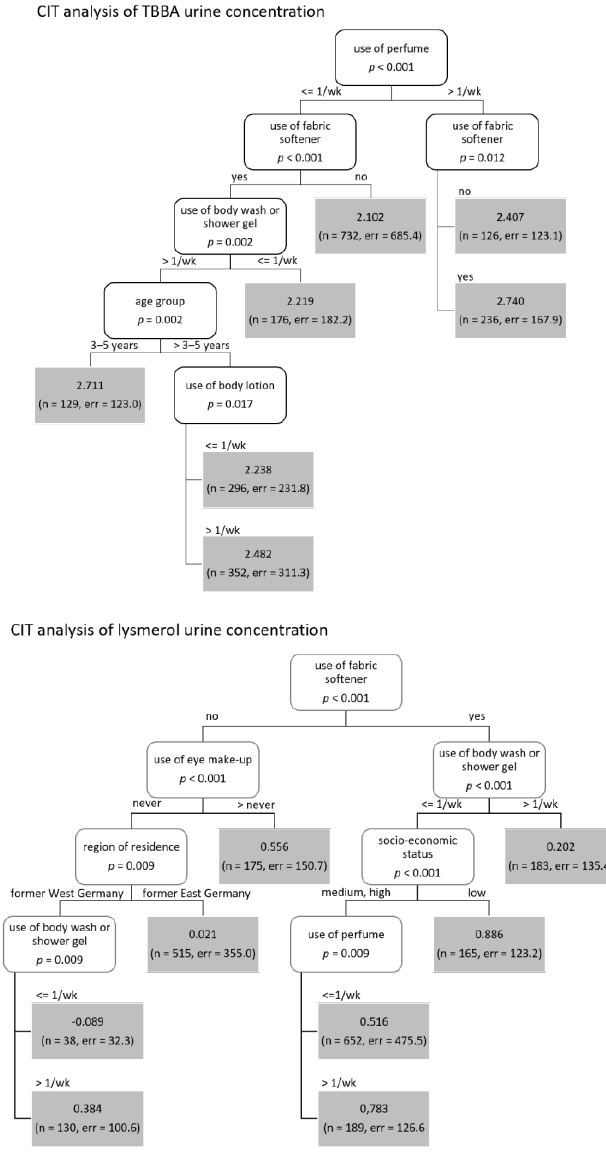
Figure 1. CIT results for volume-based TBBA and lysmerol urine concentrations for all participants.